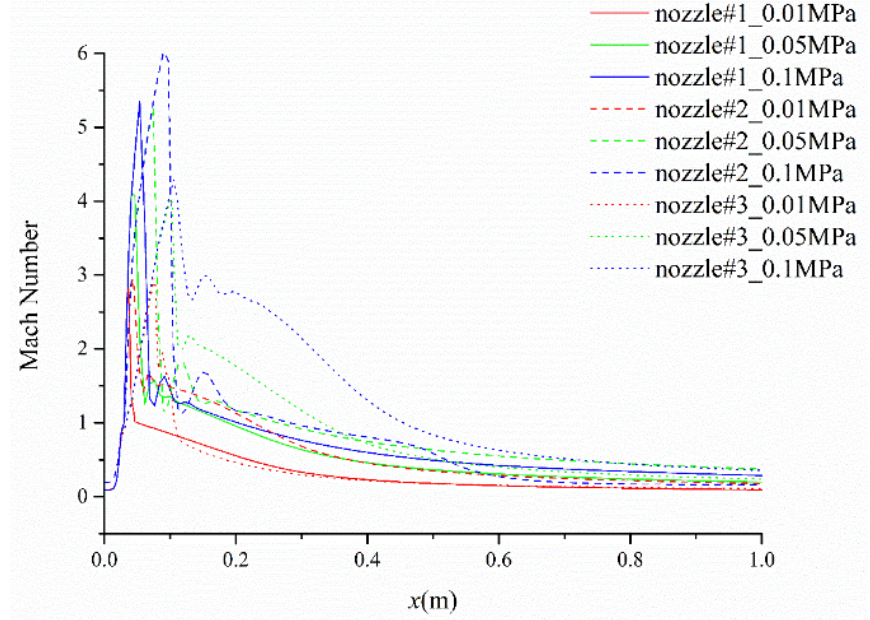
Figure 6. Mach numbers along the central axis.